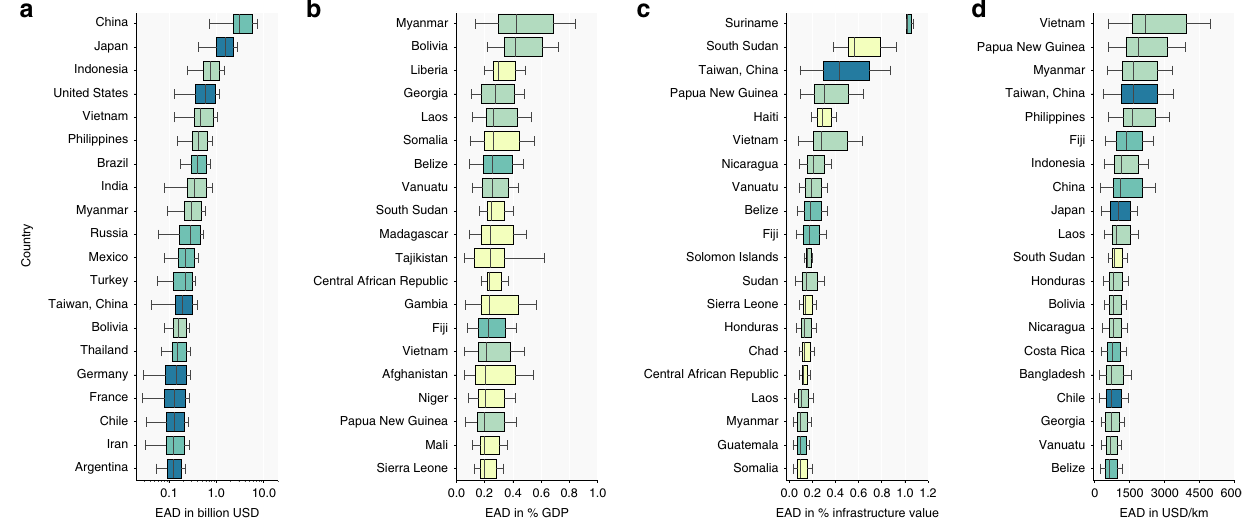
Fig. 5 Multi-hazard risk per country. Panel a presents the 20 countries that have the highest multi-hazard EAD in absolute terms. Panel b presents the twenty countries that have the highest multi-hazard EAD relative to the country ’ s GDP. Panel c presents the twenty countries that have the highest multi- hazard EAD relative to the country ’ s infrastructure value. Panel d presents the twenty countries that have the highest multi-hazard EAD per kilometer of infrastructure in that country. Supplementary Materials provide the underlying data for panels a – d for all 236 among the countries with the highest EAD as percentage of GDP.